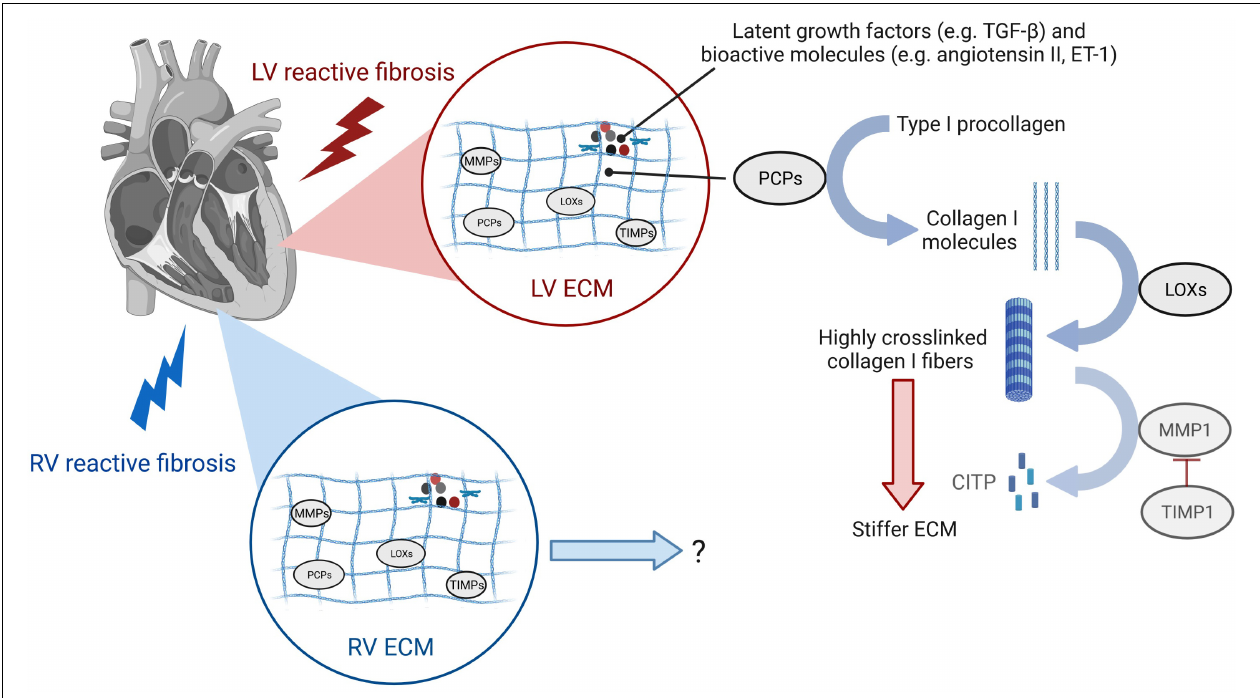
FIGURE 4 | Changes of the extracellular matrix during reactive fibrosis leading to left ventricular stiffening. Enzymes responsible for collagen turnover are induced in both LV and RV reactive fibrosis. While studies show that collagen I cross-linking and deposition of highly cross-linked collagen I fibers impact LV function by stiffening the ECM, research is needed to understand ECM remodeling of the RV and functional consequences. Type I procollagen secreted by cardiac fibroblasts is processed to type I collagen molecules by procollagen carboxy-terminal proteinases (PCPs). Lysyl oxidases (LOXs) are enzymes that cross-link adjacent type I collagen molecules to highly cross-linked type I collagen fibers that stiffen the LV and have increased resistance to degradation by matrix metalloproteinase 1 (MMP1). MMPs, along with their inhibitors TIMPs, are responsible for ECM degradation to the carboxy-terminal telopeptide of type I collagen (CITP). While the same enzymes involved in collagen-turnover are induced in the pressure-overloaded RV, the dynamics of ECM deposition and maturation, and the extent of collagen cross-linking contributing to the severity of RV stiffness require further